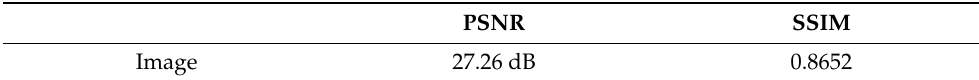
Figure 19. Airborne SAR real-time imaging results. ( a ) Matlab process result. ( b ) FPGA process result. Table 6. Result of the test image.